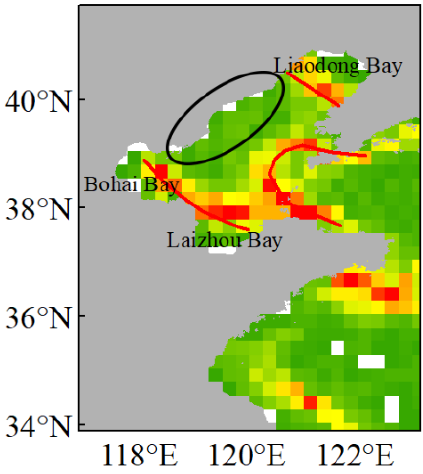
Figure 8. Three fronts in the BS (red line, the location of fronts; black ellipse, compared with previous study [7] the frequency in this region is very low).